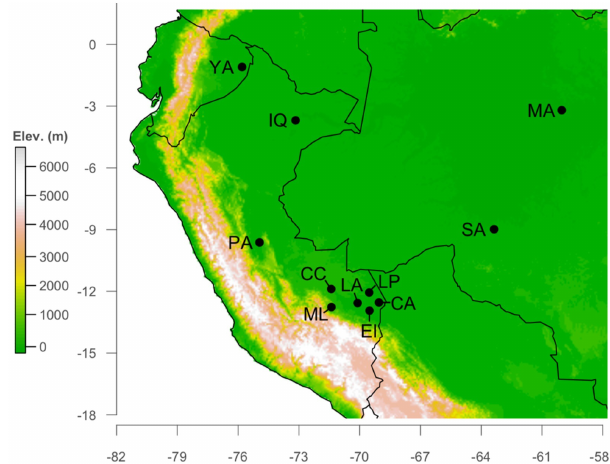
Figure 2. Localities in the western and central Amazon basin discussed in this article. YA: Yasuní National Park and Tiputini Biodiversity Station; IQ: Iquitos (Loreto, Peru); PA: Panguana Biological Station; CC: Cocha Cashu Biological Station; LA: Los Amigos Biological Station (LABS); ML: Manu Learning Centre; EI: Explorer’s Inn; CA: Cusco Amazónico; LP: Las Piedras Biological Station; SA: Samuel Hydroelectric Project (Rondônia, Brazil); MA: Manaus, Brazil. All localities are lowland rainforest sites that receive approximately 2200–3200 mm of precipitation annually, although southern sites are markedly more seasonal than those in the north.